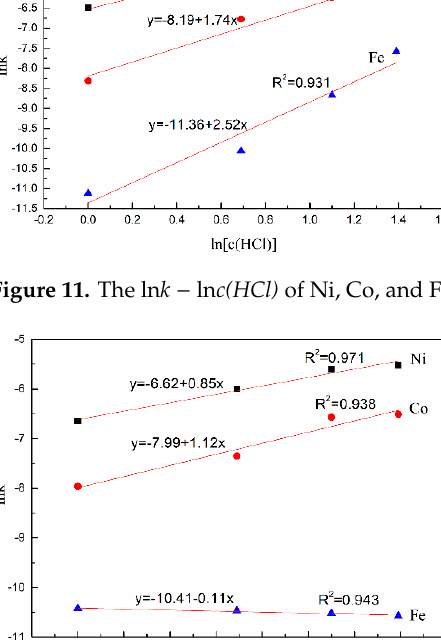
Figure 12. The ln k − ln c(NH 4 Cl) of Ni, Co, and Fe.